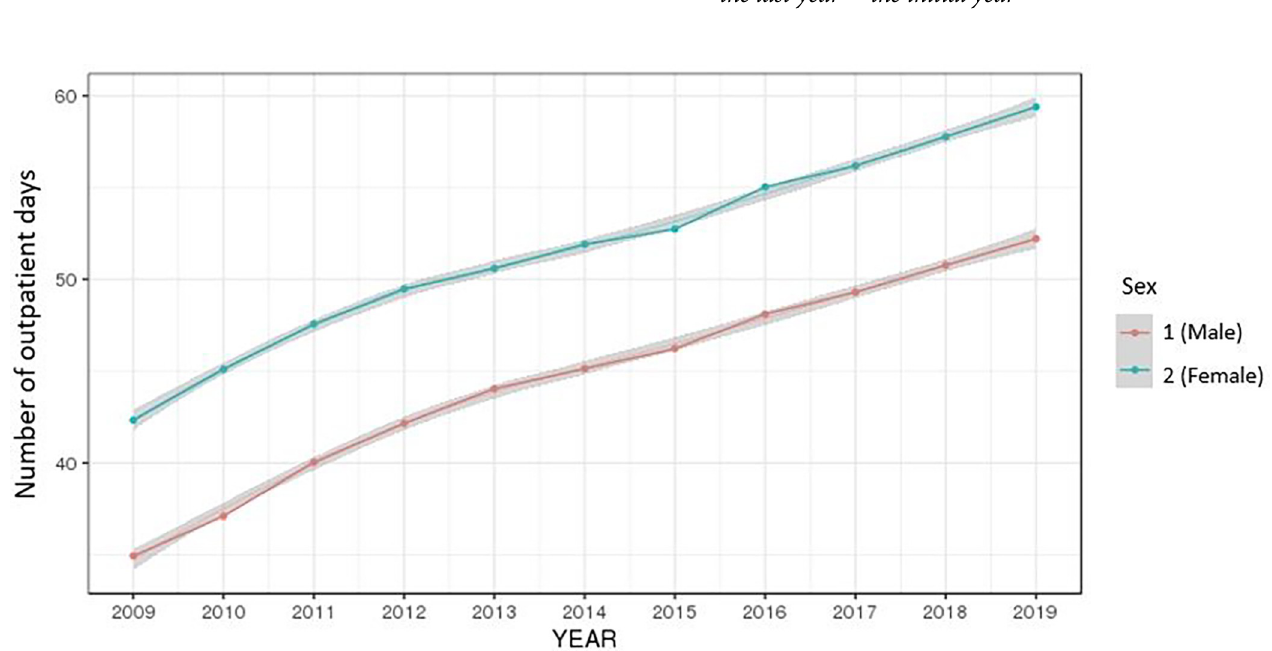
Fig 4. Ten-year trend of the number of outpatient days by